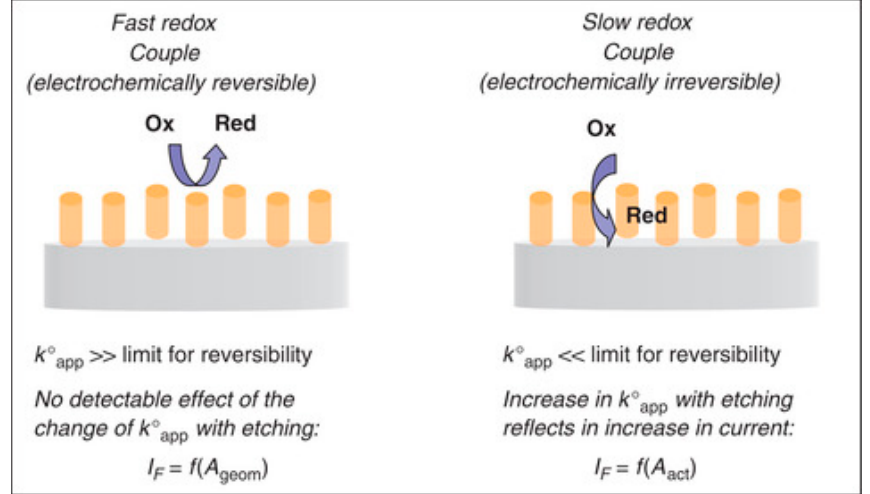
Figure 12. Sketch of the effect of different electron transfer kinetics on electrochemical responses at three-dimensional nanoelectrode ensemble (3D-NEE) (reprinted with permission from [101]).